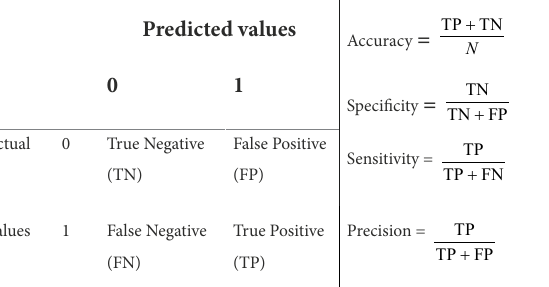
TABLE 4 Confusion matrix which tabulates the frequencies of the actual values of the dependent variable against the values predicted by the model * .